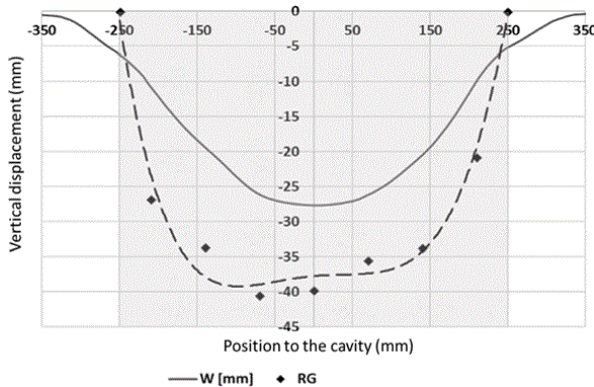
Figure 3. Vertical displacements of the RG after the cavity forma- tion and surface subsidence W .